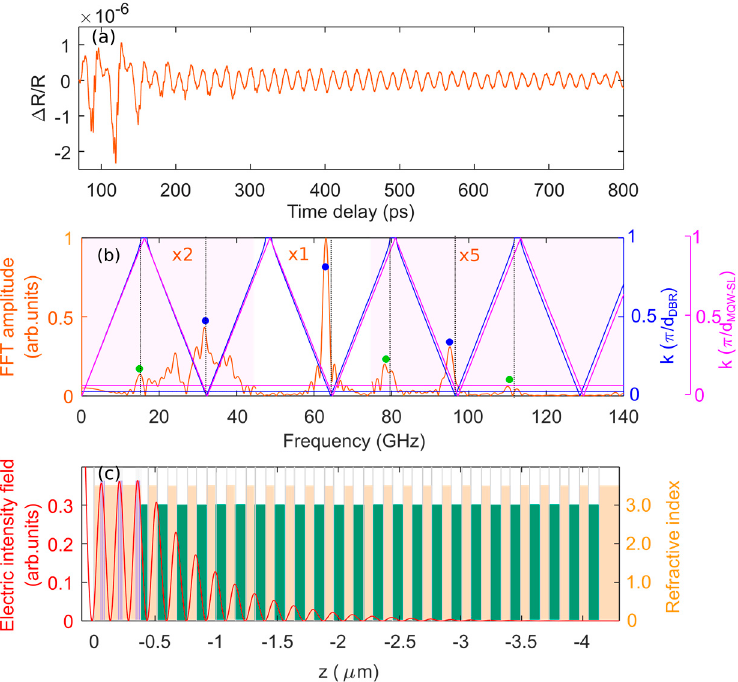
Figure 4. ( a ) Coherent acoustic phonon oscillation from 70 ps to 800 ps when background subtraction is optimized for low frequencies extraction. ( b ) FFT of ( a ) and dispersion relations in SL formed by DBR with period d DBR = 160.4 nm as well as SL formed by MQWs and GaAs spacers with period d MQW-SL = 145 nm. Brown line represents FFT, where MBZ-center modes at 32.0 GHz, 63.1 GHz and 95.1 GHz and MBZ-edge modes at 15.1 GHz, 78.3 GHz and 110.1 GHz are marked. Blue line represents dispersion relation in the DBR (horizontal blue line represents k = |2 q probeDBR − 2 π / d DBR | = 0.028 π / d DBR in the DBR). Magenta line represents dispersion relation in MQWs and GaAs spacers formed SL (horizontal magenta line represents k = |2 q probeMQW-SL − 2 π / d MQW-SL | = 0.066 π / d MQW-SL in the SL formed by MQWs and GaAs spacers). ( c ) Calculated electric intensity field (red line) in the MQW-SESAM structure given the incident pump wavelength of 1047.5 nm. The interface of air/cap layer is at position 0. Beige areas denote GaAs. Violet areas denote In 0.27 Ga 0.73 As. Green areas denote Al 0.95 Ga 0.05 As.